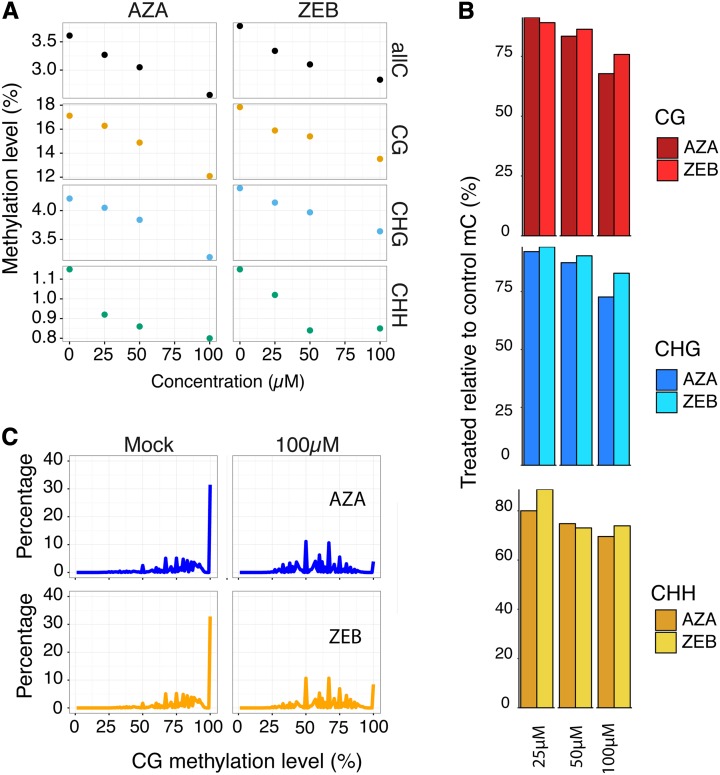
AZA and ZEB treatment result in nonselective, concentration-dependent loss of DNA methylation genome-wide. (A) The genome-wide methylation level of the control seedlings (0 µM) and seedlings treated with 25 µM, 50 µM, and 100 µM of either AZA or ZEB. (B) The methylation level of AZA- and ZEB-treated seedlings relative to the untreated control (treated/control) shown side-by-side for each context of DNA methylation. Both AZA and ZEB were compared to the untreated control methylation levels. (C) A frequency distribution of the methylation levels of individual methylated cytosines for both AZA and ZEB treatments and the controls. In mock-treated samples, many methylated CG sites are 100% methylated, whereas in treated samples, most of the sites are not completely methylated.